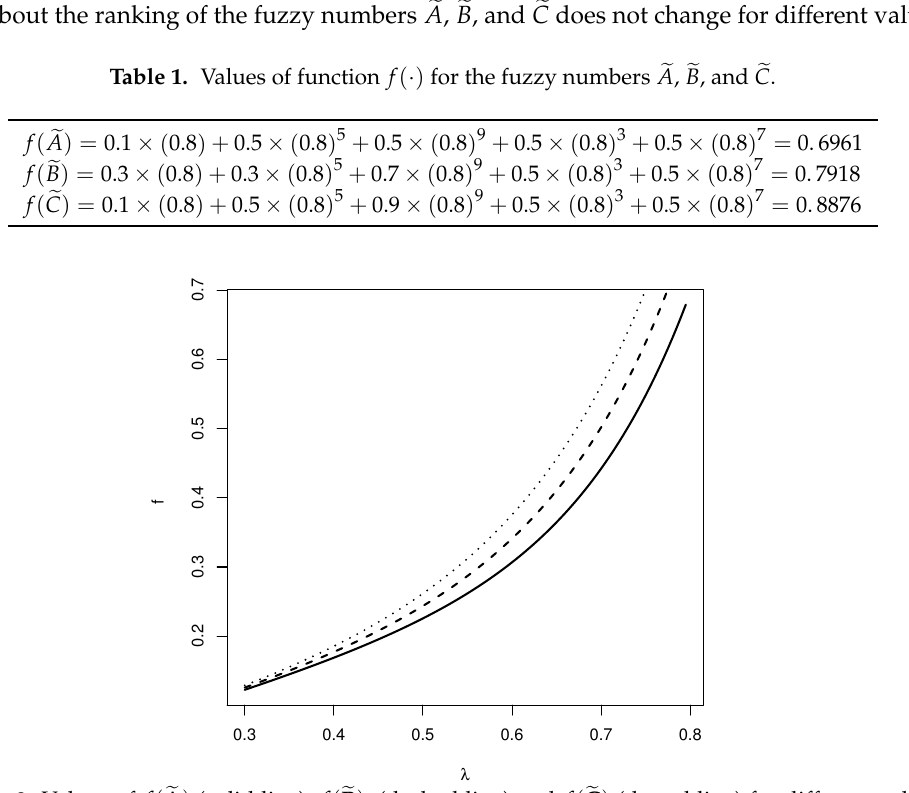
Figure 3. Values of f ( (cid:101) A ) (solid line), f ( (cid:101) B ) , (dashed line) and f ( (cid:101) C ) (dotted line) for different values of λ